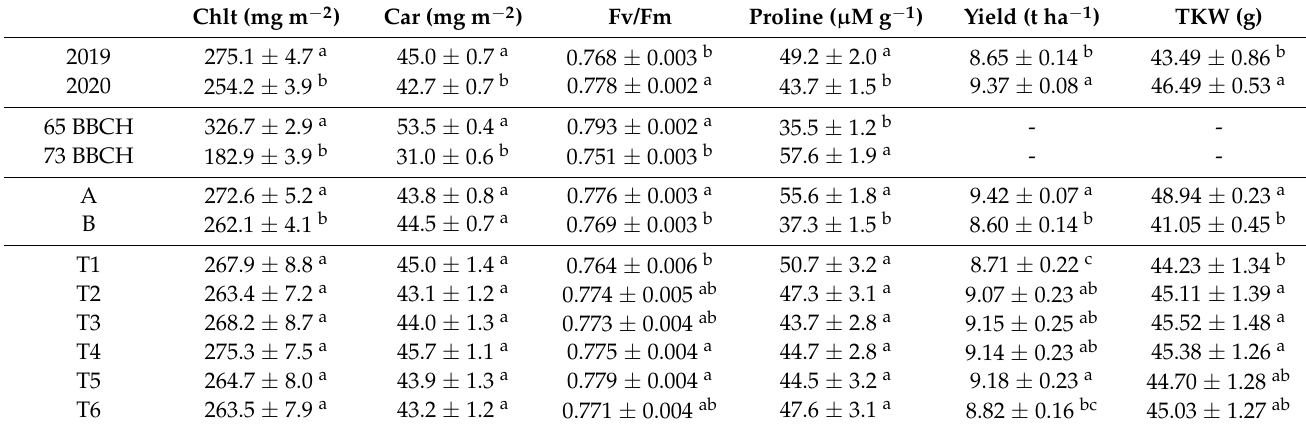
Table 2. Total chlorophylls (Chlt), carotenoids (Car), the maximum quantum yield of PS II (Fv/Fm), proline content, yield, and thousand-grain weight (TKW). The values given are means ± SE for 2019 and 2020, phenological phases 65 and 73 BBCH, cultivars KM-72-18 (A) and KM-94-18 (B) and individual stand treatments (T1–T6). LSD post hoc test. Different letters differ significantly at p <